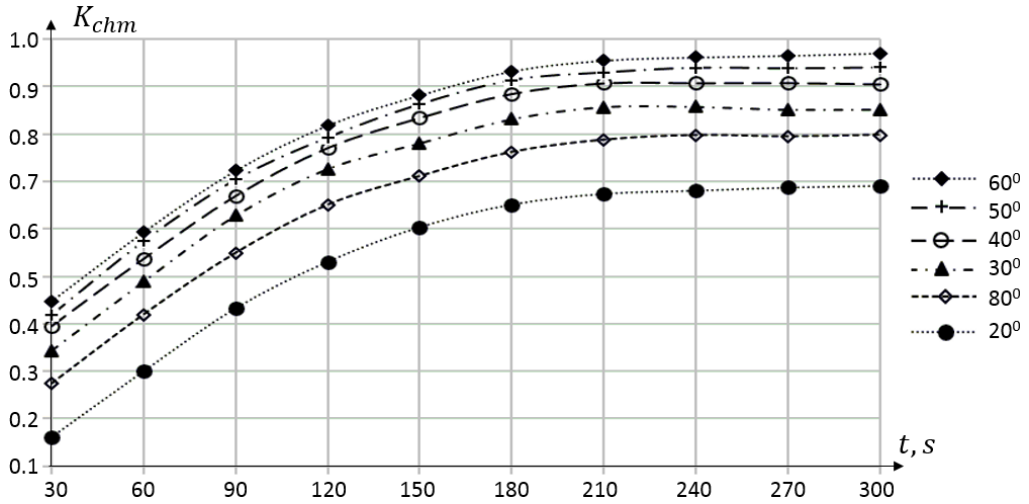
Figure 8. Homogeneity coefficient of foam concrete mixture vs. mixing time t at different tilt angles of the conical part of turbulent mixer (experimental data).